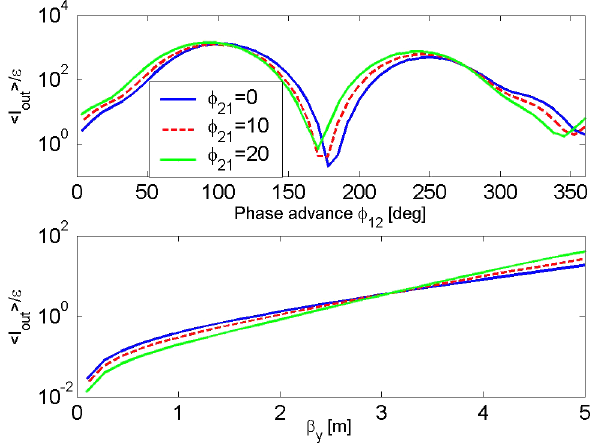
=" in the last turn (calculated over the FIG. 9. Average I out ) bunch train) as a function of the CR vertical phase advance ( ’ 12 ¼ 2 mm , Y ¼ 0 , and vertical (cid:5) function at the RFDs ( Y in1 in2 ¼ (cid:5) ¼ 5 m , (cid:6) ¼ (cid:6) ¼ 0 , ’ ¼ ’ ¼ 30 deg , (cid:5) y 1 y 2 y 1 y 2 12 21 ¼ 400 , N ¼ 4 ). N bunches turn